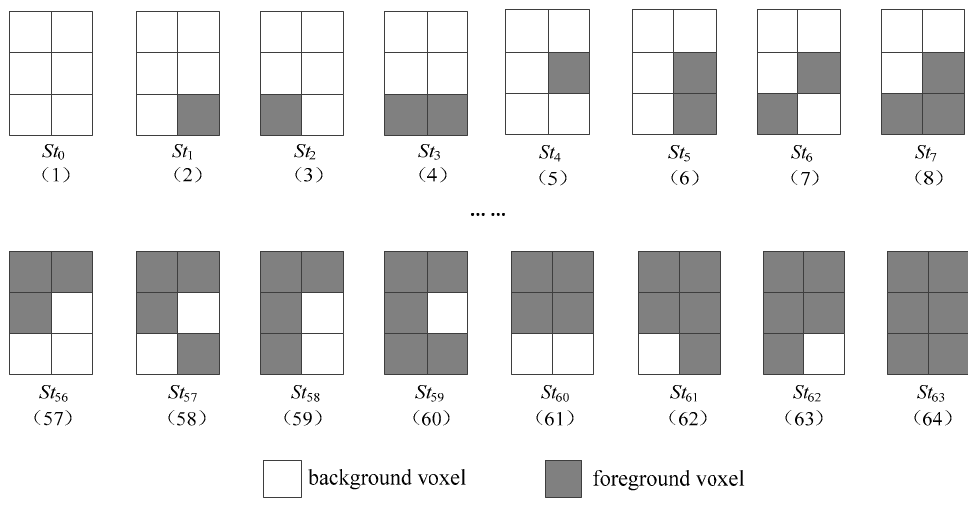
Figure 6. Sixty-four states de fi ned in processing three rows simultaneously.